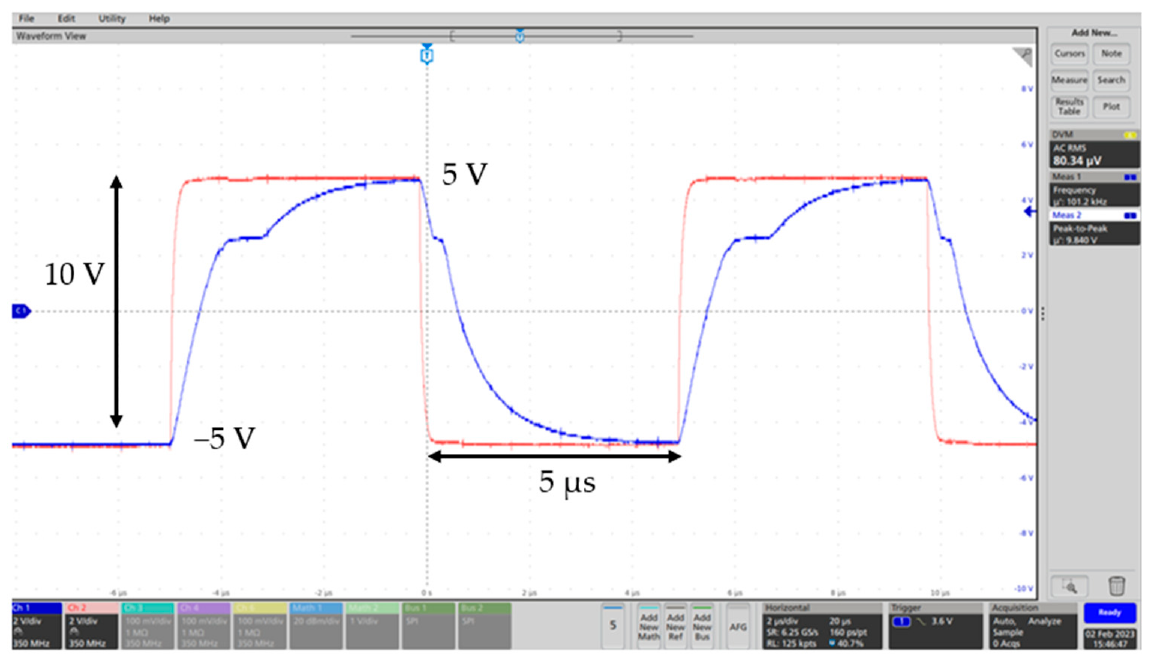
Figure 8. Measured gate (blue) and gate driver (red) voltage transitions at 100 kHz switching frequency with a 50% duty cycle. Peak-to-peak voltage for gate driver voltage is 10 V. In Figure 9, a zoom for switching gate (red) and drain (blue) transition at 100 kHz is shown. It is possible to distinguish two time intervals in the drain falling transition, the first lasting almost 125 ns and the next lasting almost 600 ns.